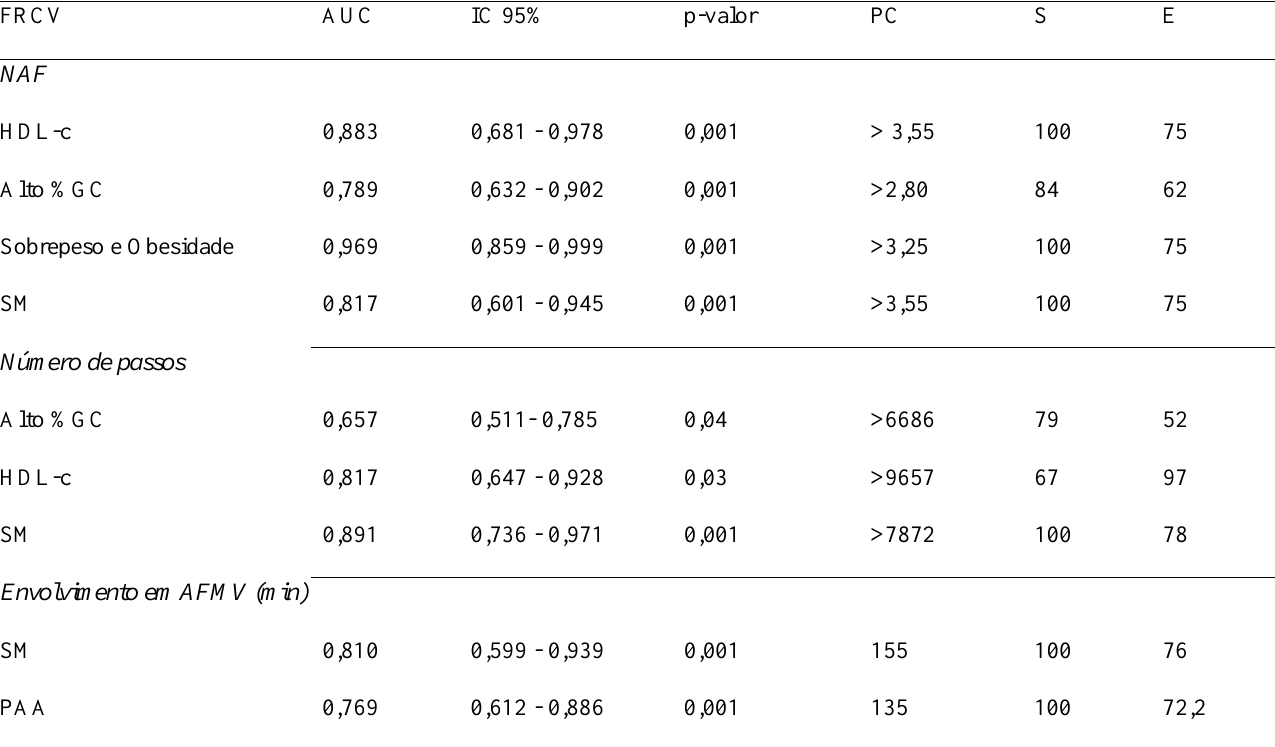
Tabela 3.Predição de fatores de risco cardiovasculares em meninos, por meio de NAF, número de passos e minutos de envolvimento em atividade física de moderada a vigorosa